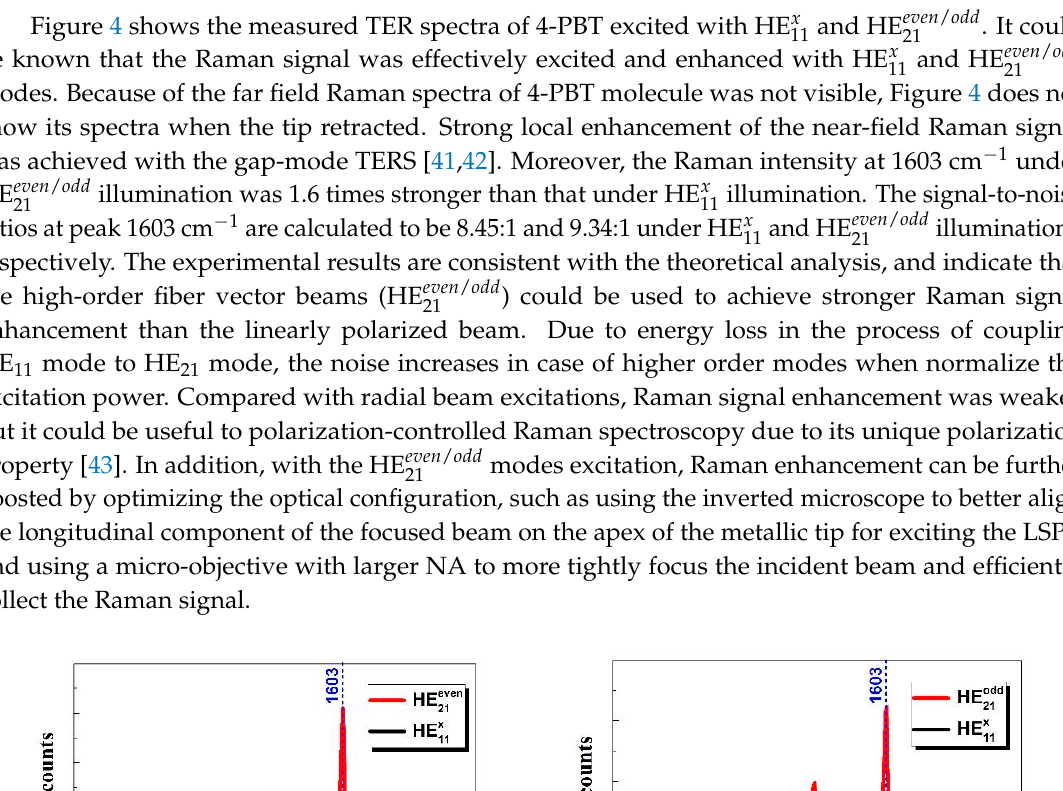
Figure 3. ( a 1 , b 1 ) Images of HE x absence of a polarizer; ( a 2 , b 2 ) Images of HE even polarizer; ( a 3 – a 6 , b 3 – b 6 ) Images of polarization orientations. The image sizes are 2.5 mm × 2.5 mm.